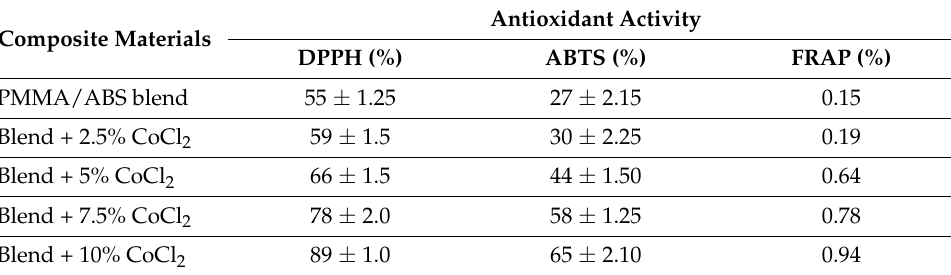
Table 3. Free radical scavenging data of PMMA/ABS films with 2.5–10% cobalt chloride. Composite